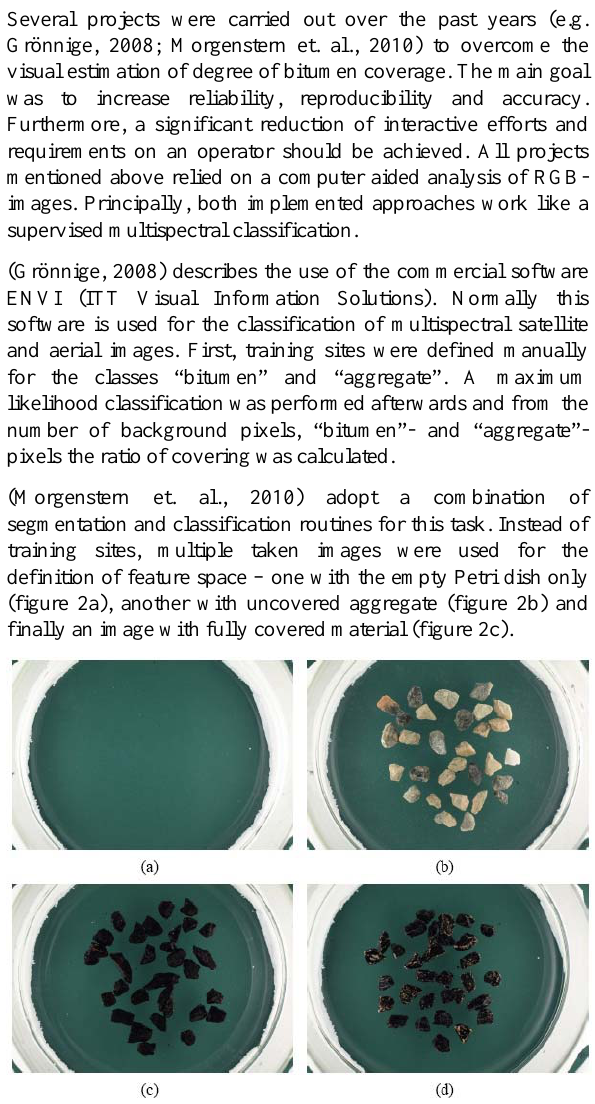
Figure 2: Probabilistic segmentation based on color images. Reference images for background (a), for aggregate (b) and bitumen (c). Material probe in a Petri dish (Morgenstern et. al., 2010).